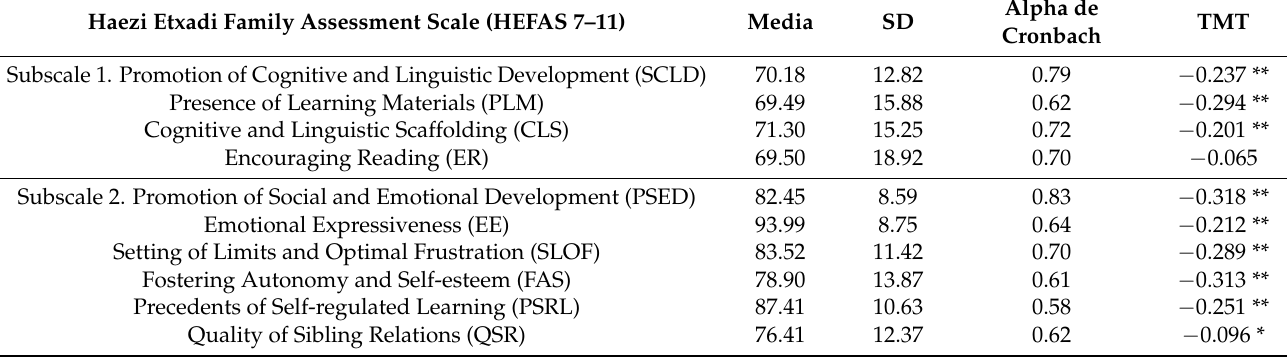
Table 3. Descriptive statistics, Cronbach’s Alpha coefficient, and correlations through Pearson’s coefficient (r) between the factored HEFAS (7–11) and the executive function variable evaluated with the